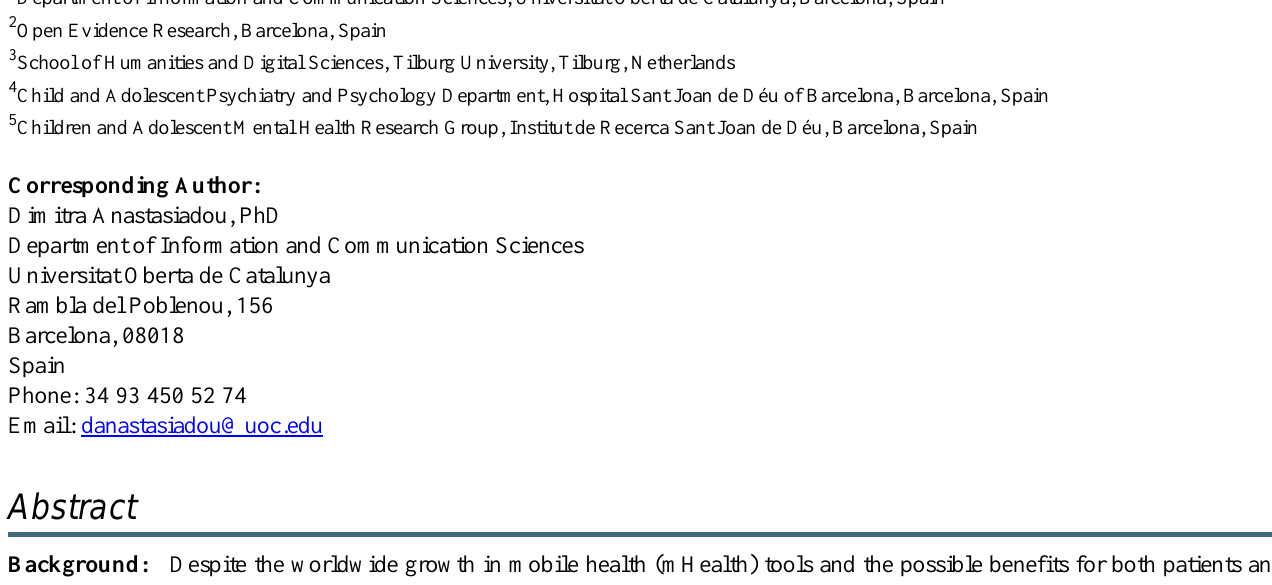
eating disorders; mental health; mHealth; mobile applications; focus